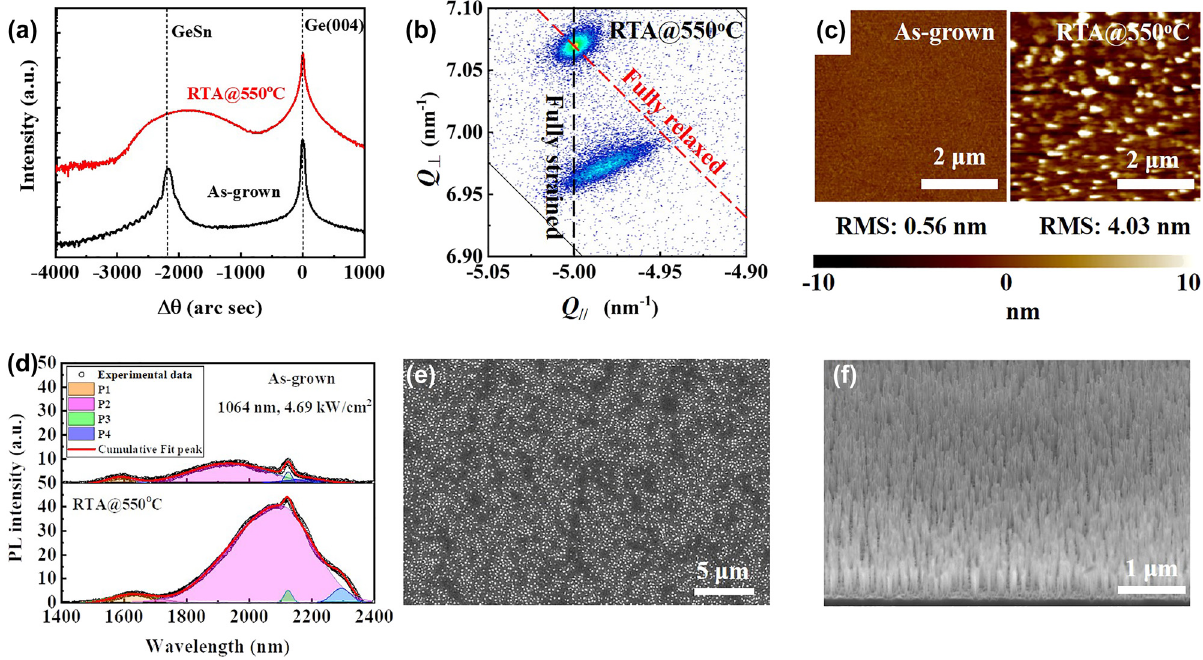
Figure 1: Structural characterization of as-grown GeSn film, annealed GeSn film and GeSn NWs. (a) XRD (004) 𝜔 − 2 𝜃 rocking-curve scans of GeSn grown on Ge substrate by MBE before (black curve) and after (red curve) RTA at 550 ◦ C. (b) (224) XRD-RSM of GeSn after RTA at 550 ◦ C. (c) AFM images of the GeSn sample before (left panel) and after (right panel) RTA at 550 ◦ C. (d) Room temperature PL spectra of the GeSn sample before (upper panel) and after (lower panel) RTA at 550 ◦ C. (e) Top-view and (f) tilted-view SEM images of the GeSn sample after RTA at 550 ◦ C and subsequent Cl-based ICP dry